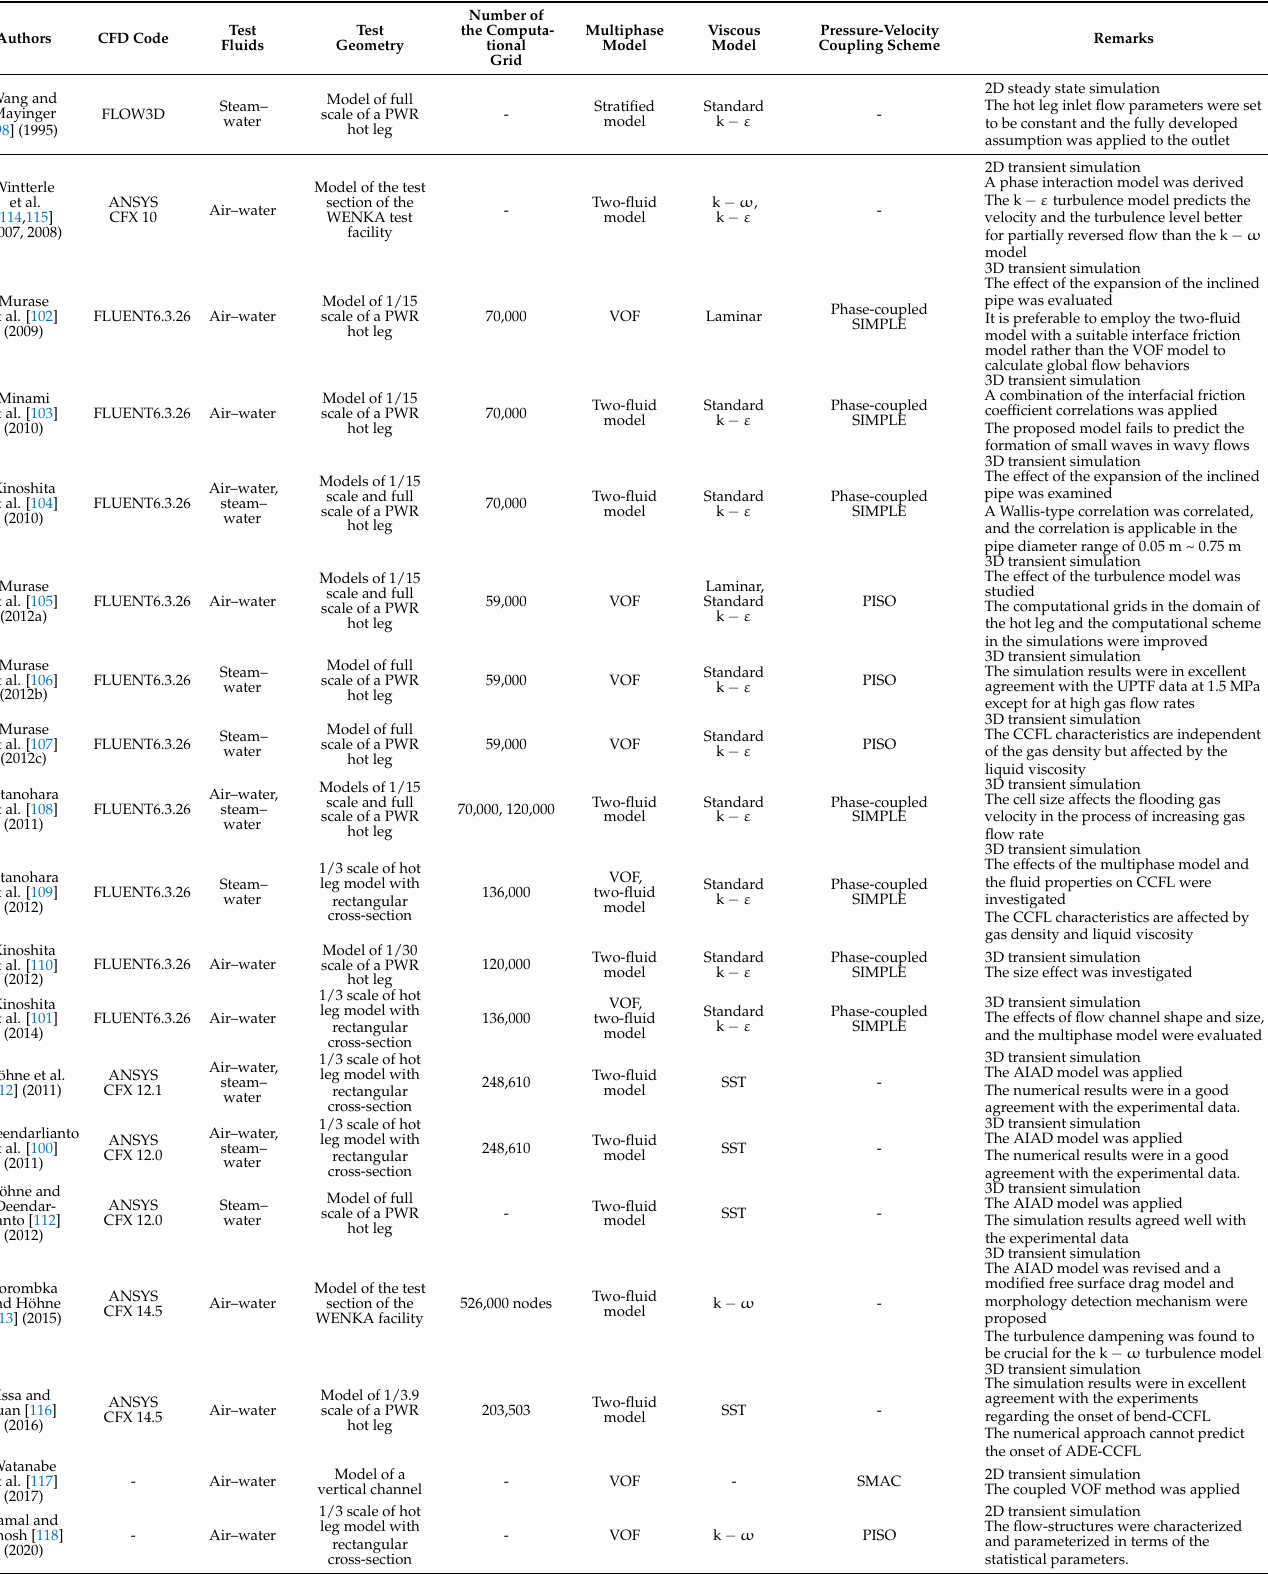
Table 9. Summary of the numerical studies on CCFL.